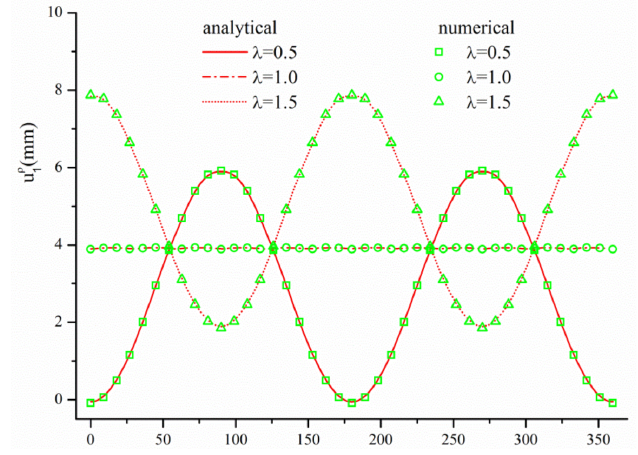
Figure 6. A comparison of radial displacements of points at the inner boundary of the